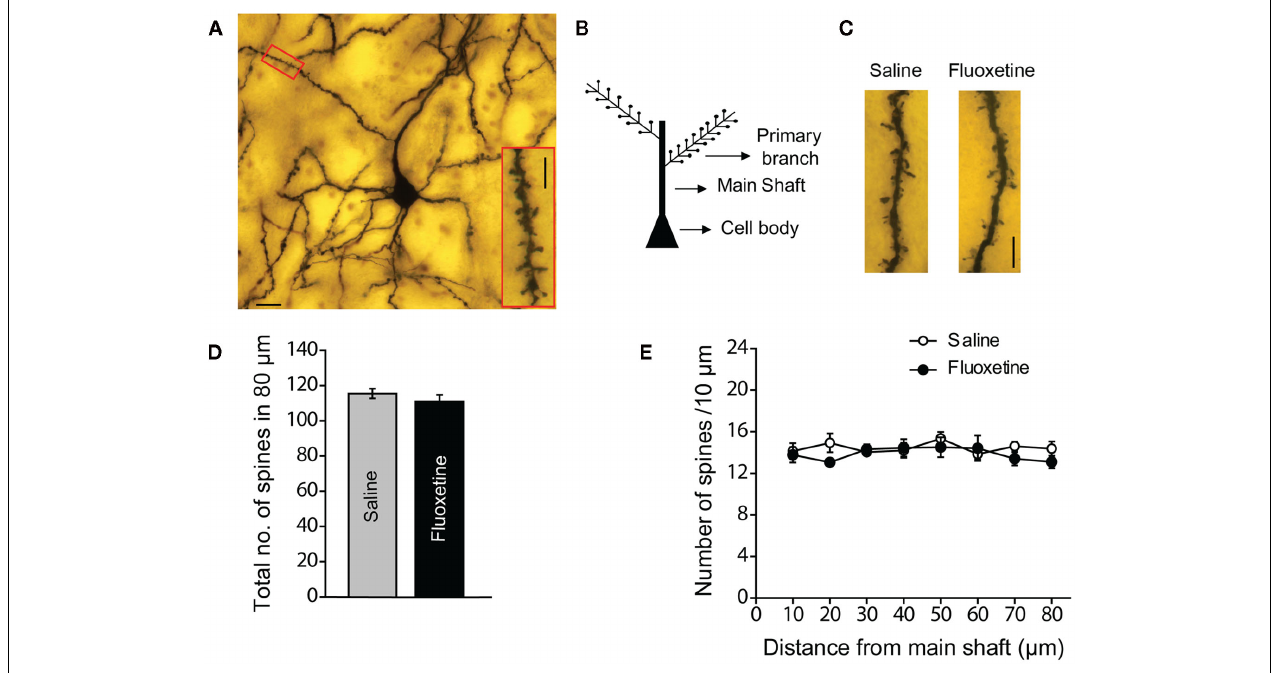
(C) Representative dendritic segments from BLA spiny principal neurons of saline and fluoxetine injected animals; scale bar: 5 μ m. (D) Total number of spines in the 80 μ m stretch of the dendrite analyzed. (E) The distribution of spine density over 10 μ m segments along the 80 μ m stretch of the dendrite analyzed. Saline: N = 5, Fluoxetine: N = 5. Error bars represent